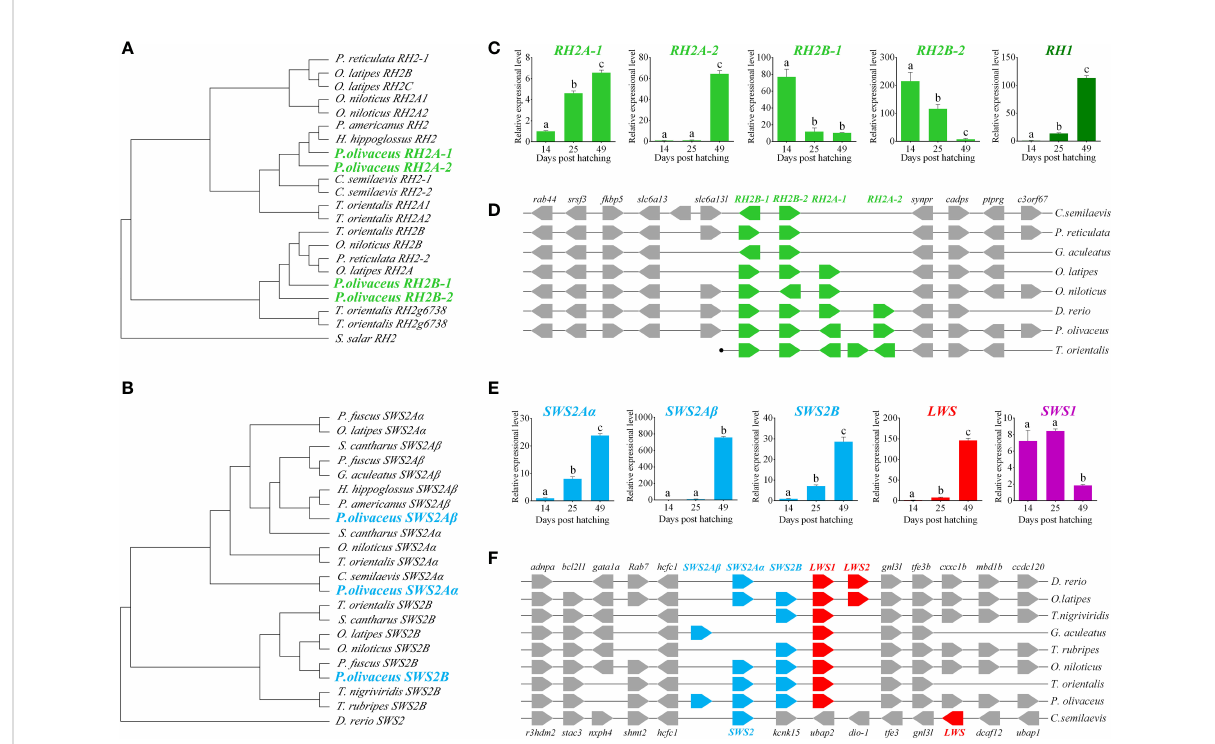
FIGURE 1 Charactorization of opsin genes in P. olivaceus . (A, B) The phylogenetic analysis of RH2 and SWS2 genes. (C) The expression of RH genes during the process of metamorphosis in P. olivaceus. (D) Syntenic analyses of RH genes in teleosts. (E) The expression of SWS genes during the process of metamorphosis in P. olivaceus. (F) Syntenic analyses of SWS genes in teleosts. Different letters represent signi fi cant